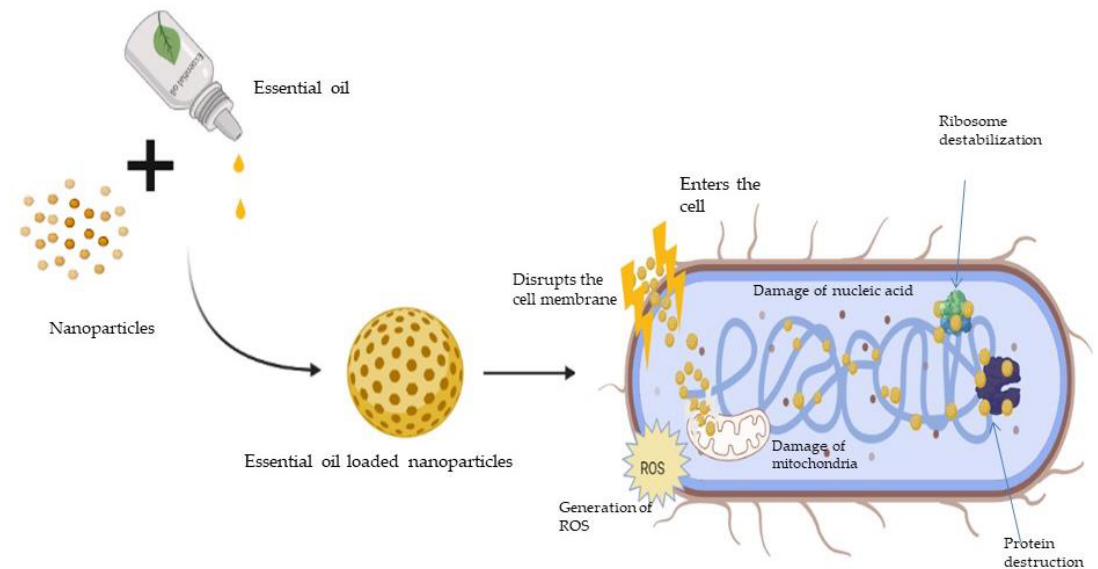
Figure 1. Mechanism of action of antimicrobial activity of essential oils.